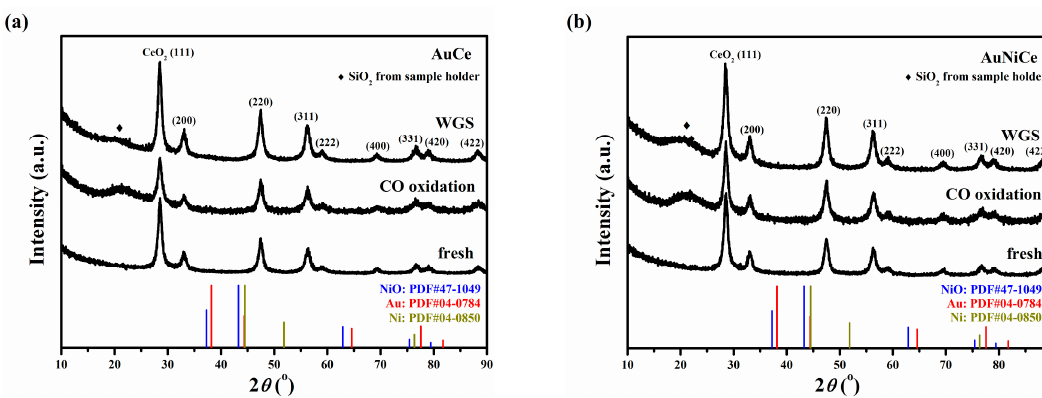
Figure 5. XRD patterns of AuNi/CeO 2 samples before and after different reactions: ( a ) AuCe ; ( b ) AuNiCe .